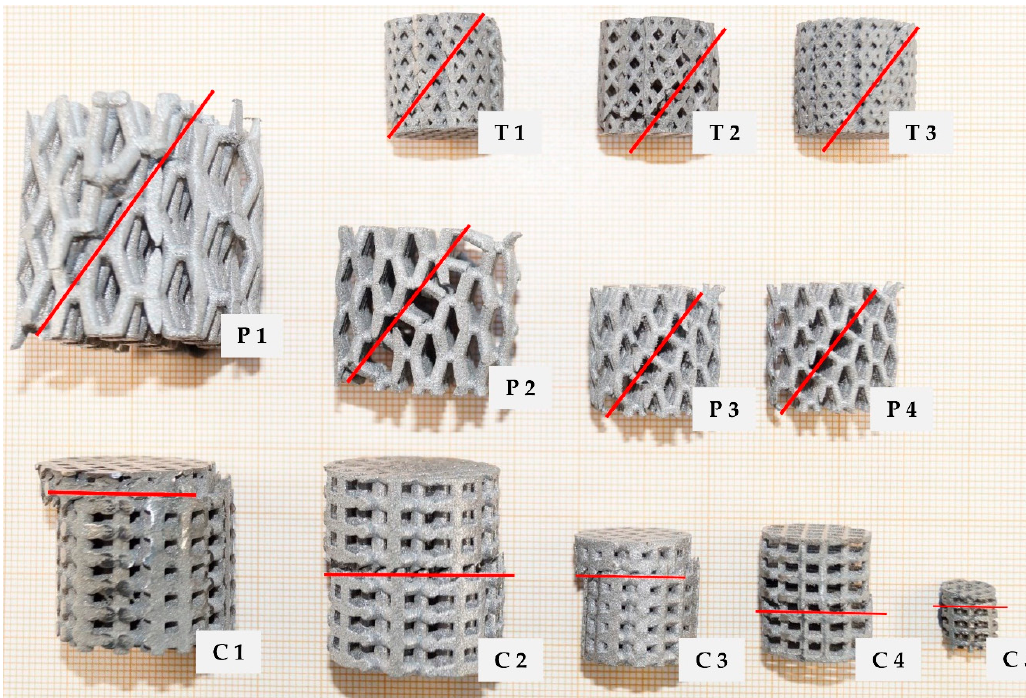
Figure 5. Macroscopic view—overview of tested samples. Failure courses are identified in these figures by a red line for the macroscopically visible line of fracture. Twisted and pyramidal designs showed shear deformation at an angle of ca. 45°. The cubic design showed a layer ‐ by ‐ layer failure mechanism.